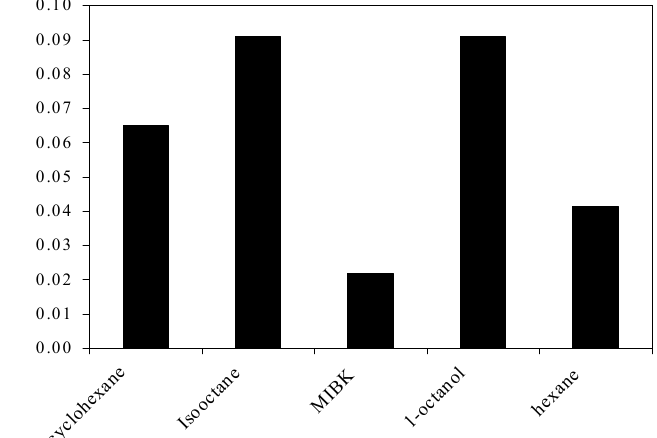
Figure 4. Distribution coefficients of L(+) tartaric acid between water and solvents used in this